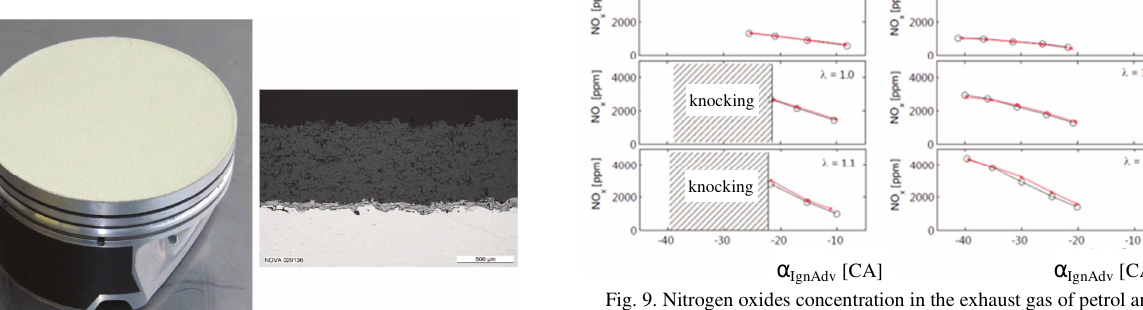
Fig. 6. Method of covering the piston with catalytic and thermal surfaces